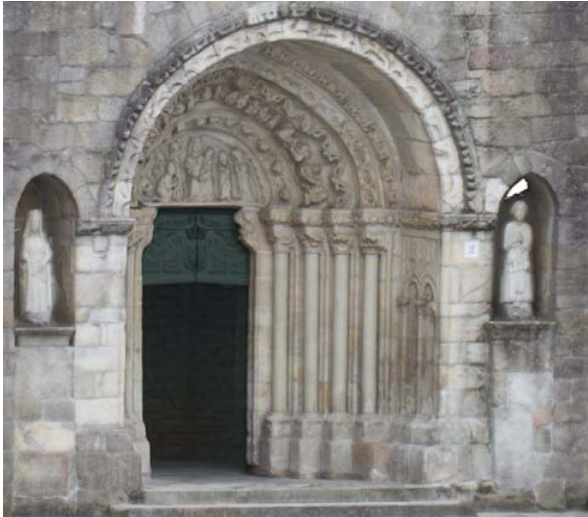
Figure 16. Doorway detail: orthographic perspective of the Textured Model getting from the DSM (from decimated Mesh).